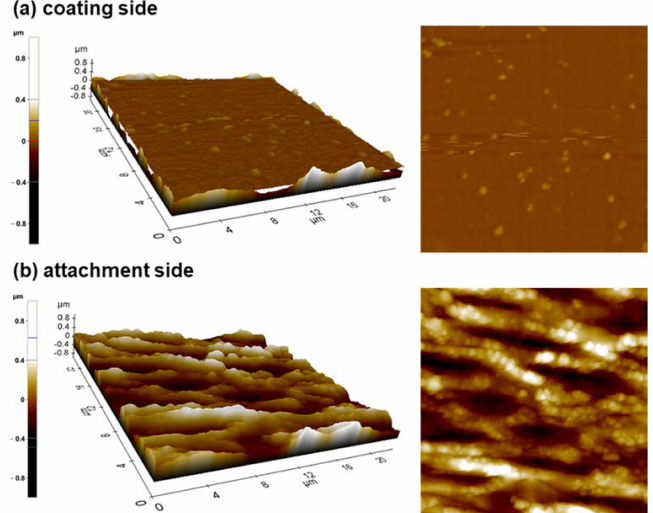
Figure 5. AFM surface morphology of PVAc-H 2 O 2 tooth whitening composition; ( a ) coating side and ( b ) attachment side of bovine